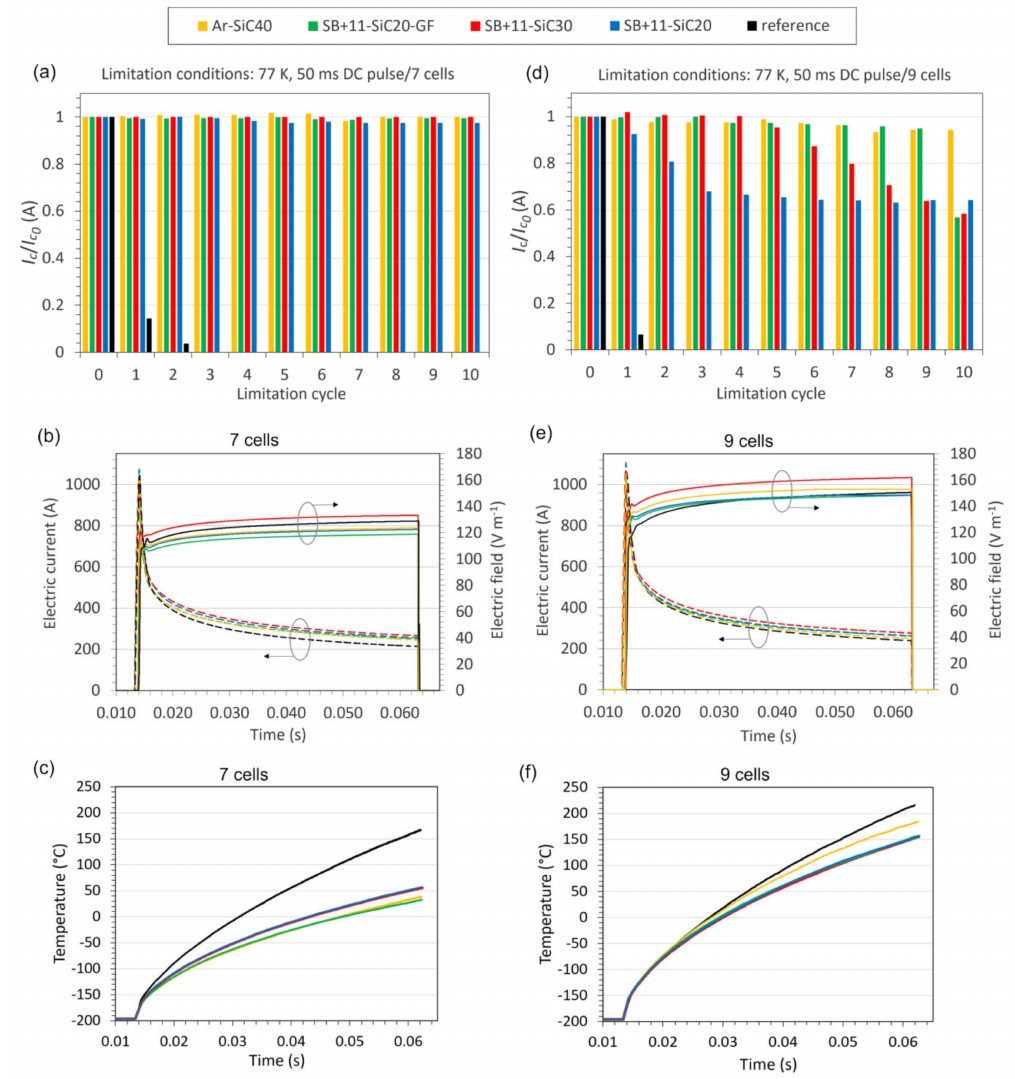
Figure 9. Dependence of normalized critical current on number of limitation cycle for investigated systems Ar-SiC40 (yellow), SB + 11-SiC20 (blue), SB + 11-SiC30 (red), SB + 11-SiC20-GF (green) and bare CC tape as reference (black) during limitation experiments with 7 ( a ) and 9 cells ( d ). Measured electric fields and currents are shown in ( b ) and ( e ). Temperatures developed in the samples using 7 and 9 cells are depicted in ( c ) and ( f ), respectively.